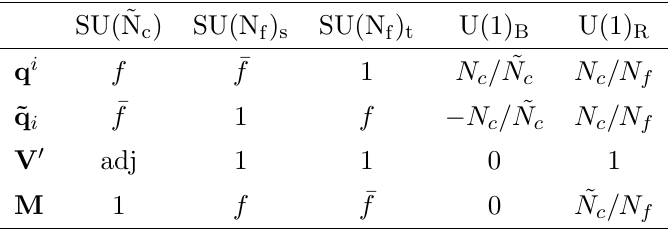
Table 2 . The matter content of magnetic N = 1